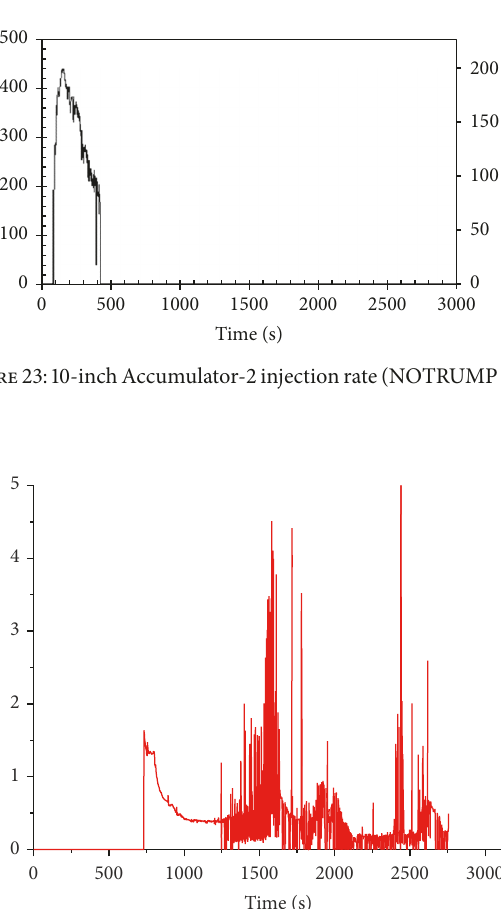
Figure 24: ADS-1 discharge flow rate.